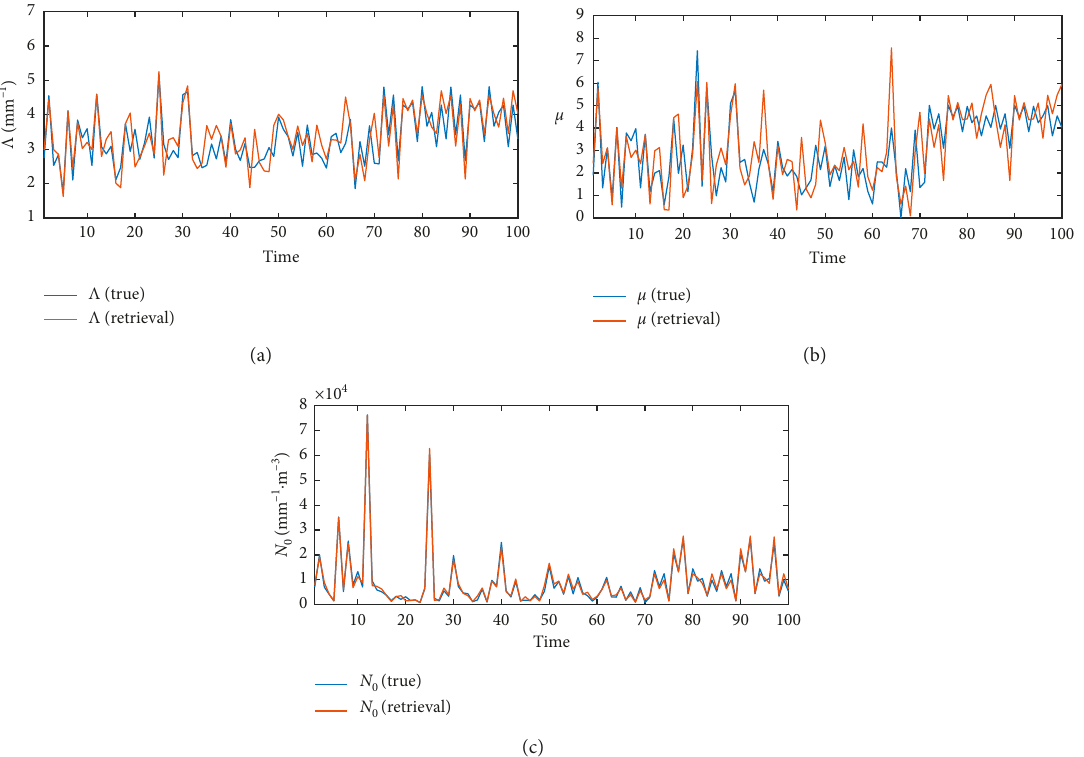
Figure 4: Retrieval results of the DSD parameters (first group); the blue line and the red line represent the true values and the retrieval values, respectively: (a) time sequence of Λ ; (b) time sequence of μ ; (c) time sequence of N 0